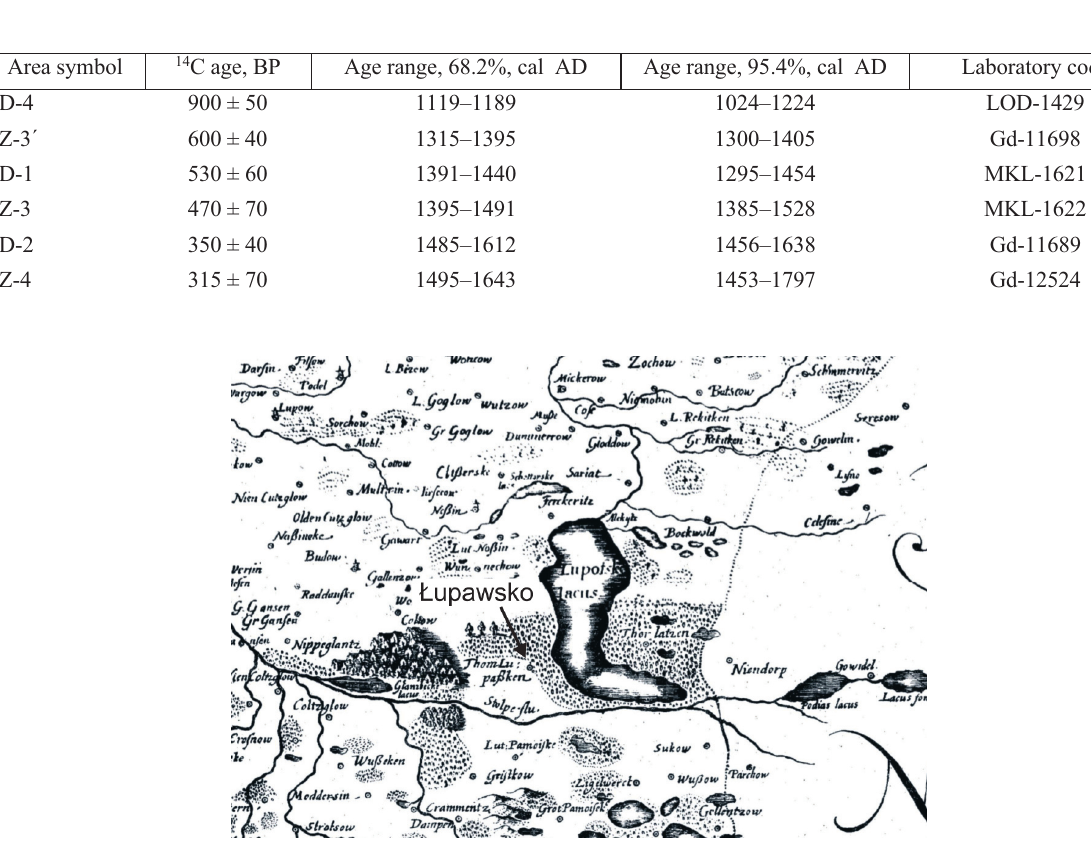
Fig. 3. Lake Jasień region (Lupofske Lacus) with visible forest areas on the map of Lubben (1618) with marked location of the village of Łupawsko (thom